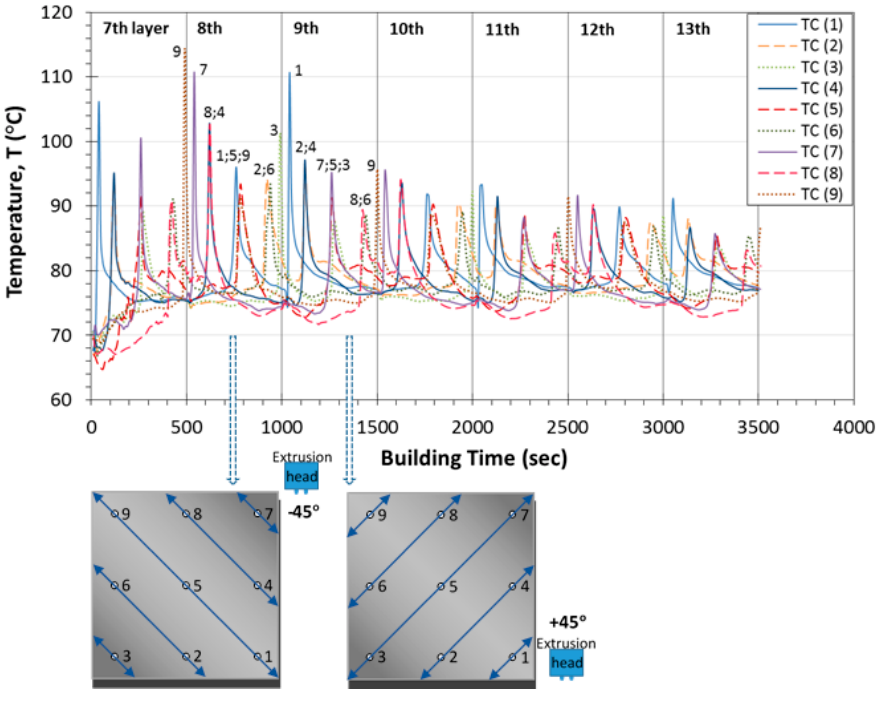
Figure 6. Mapping of temperature profiles generated within the FDM square plate specimens during the whole fabrication process.